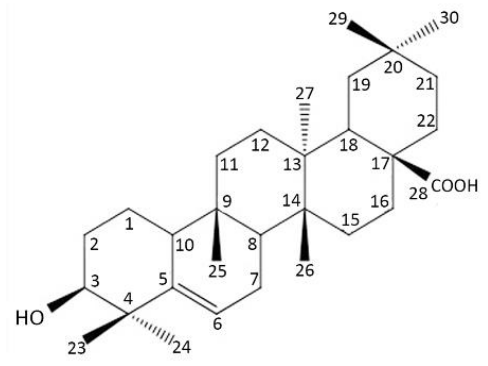
Figure 1. Structure of pinnatane A.